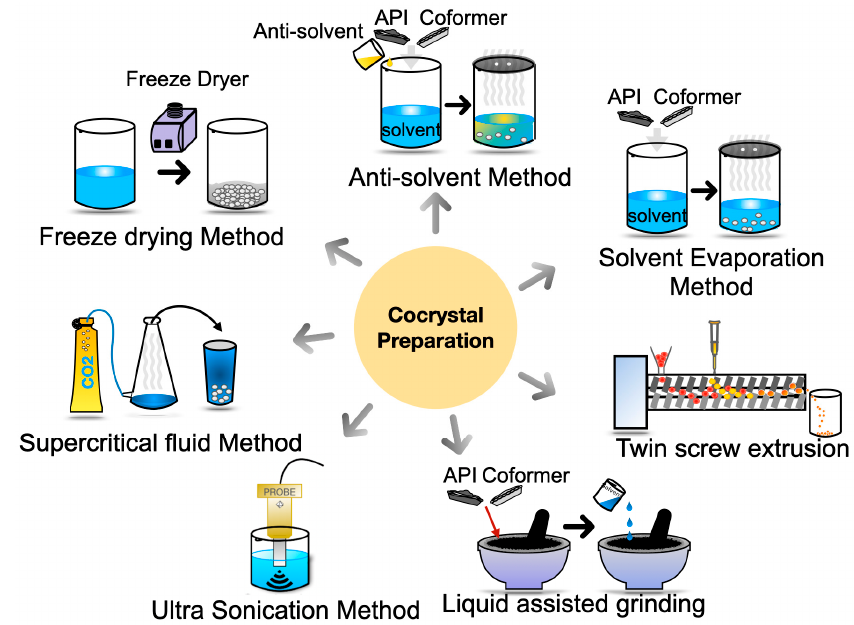
Figure 1. Techniques utilized for cocrystal preparation.